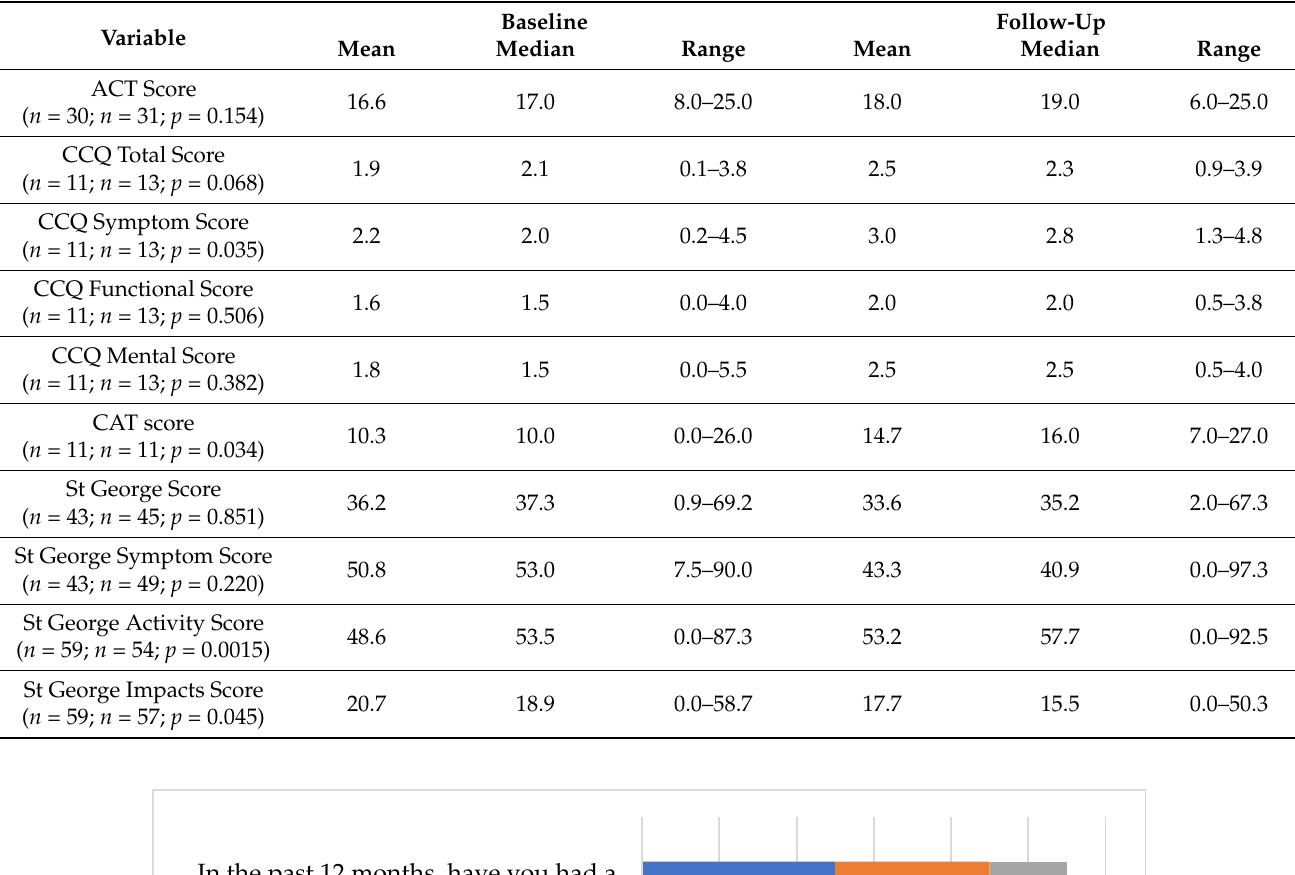
Table 3. Comparison of validated test scores at baseline and follow-up. p -values were obtained from the paired t -test to compare the change in means from baseline to follow-up.